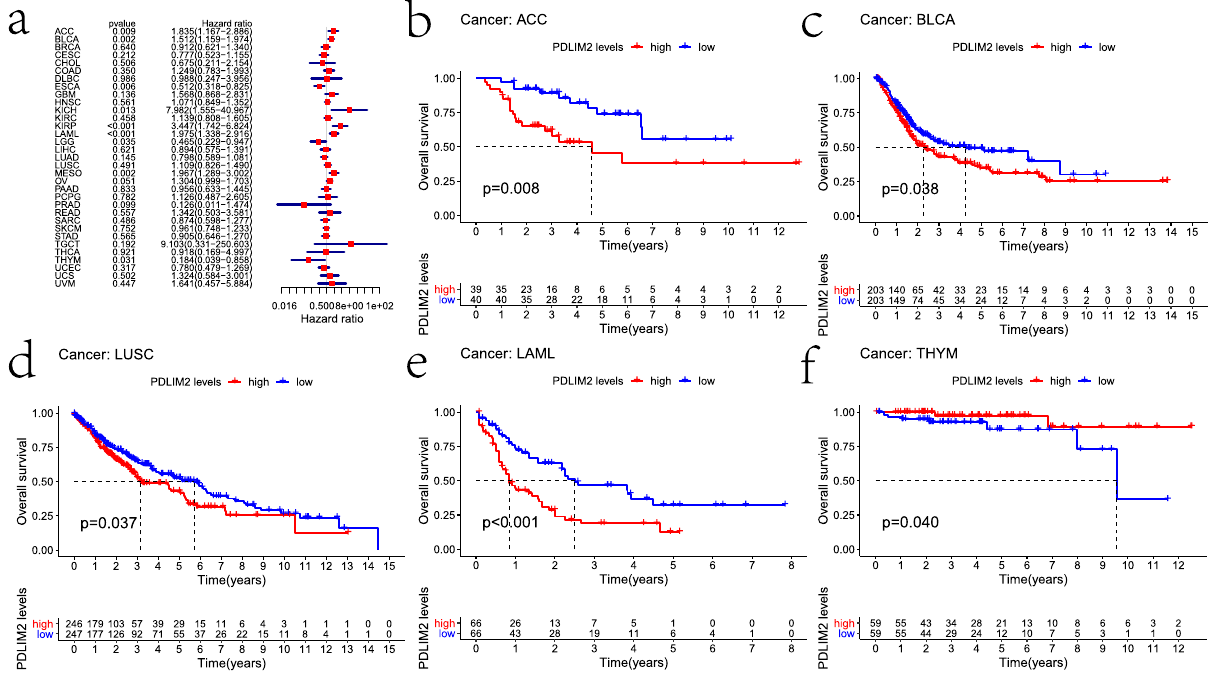
Figure 2. Correlation between PDLIM2 and overall survival of various cancer types of TCGA dataset by R (3.6.3 version; The R Project for Statistical Computing, Vienna, Austria). ( a ) Multivariate Cox regression analysis to identify prognosis in 33 tumors. Red squares represent the hazard ratio. ( b – f ) Kaplan–Meier survival curves comparing the high and low expression of PDLIM2 in different types of cancer ( b ) in ACC, ( c ) in BLCA, ( d ) in LUSC, ( e ) in LAML, ( f ) in THYM. ACC: adrenocortical carcinoma; BLCA: bladder urothelial carcinoma; LUSC: lung squamous cell carcinoma; LAML: acute myeloid leukemia; THYM: